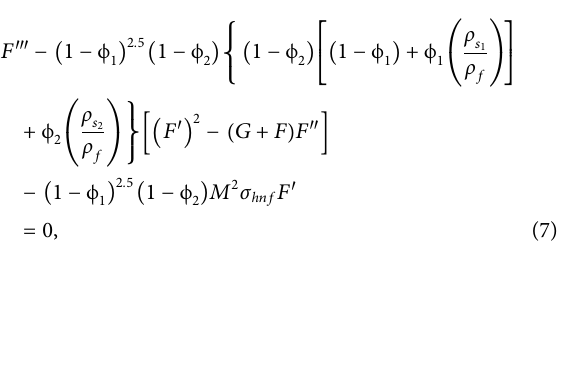
Using similarity transformation and thermo-physical characteristics in the governing model, the fi nal version of the model is achieved: